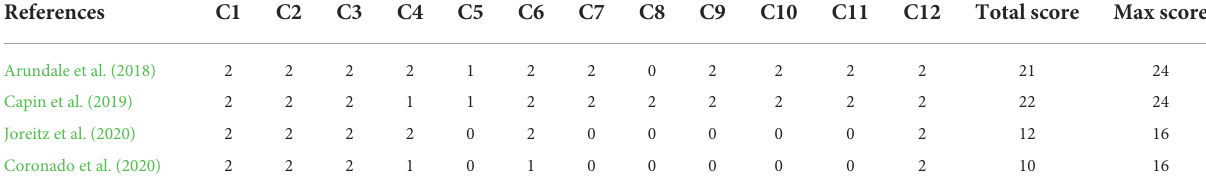
TABLE 2 Methodological quality assessment